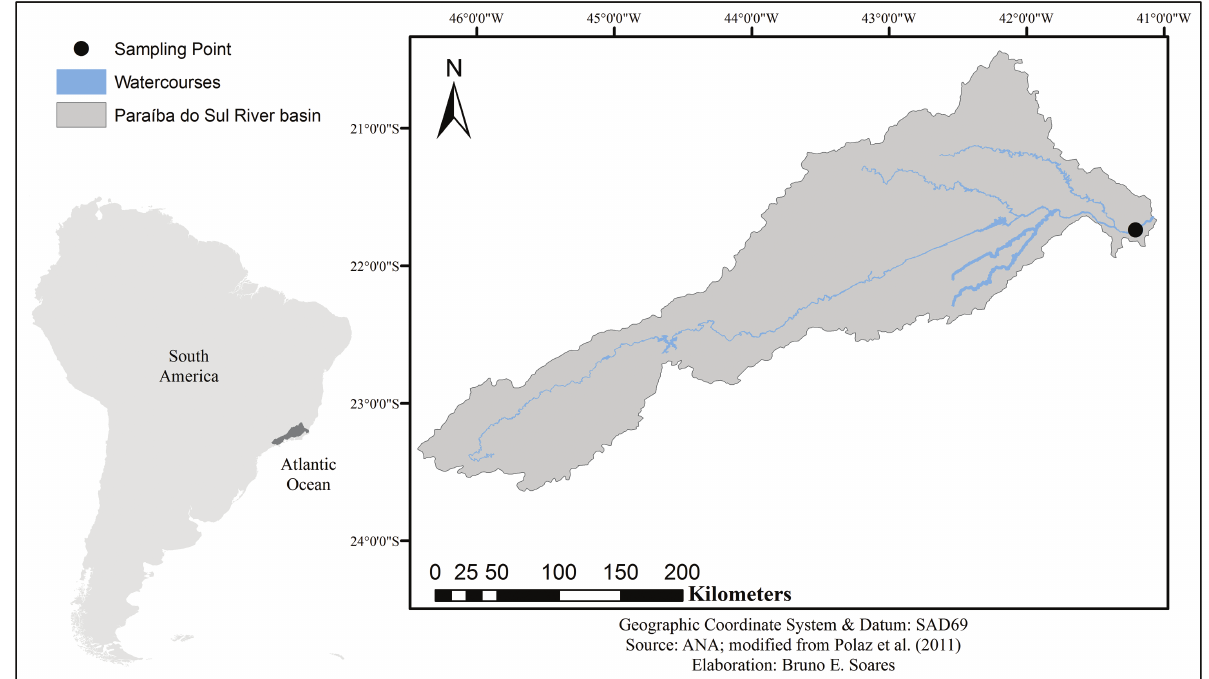
Fig. 1. Sampling area in the Paraíba do Sul River, where sampling was carried out from August 2011 through February